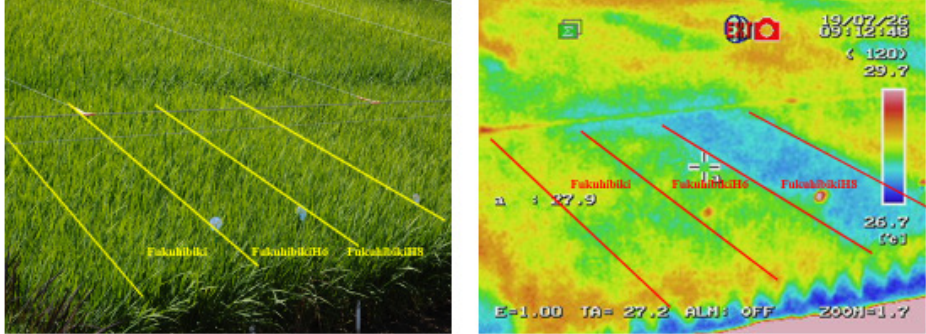
Figure 4. Yield evaluation ( left ) and thermo-camera observation ( right ) of FukuhibikiH6 and FukuhibikiH8 at maximum tillering stage in paddy field in Ibaraki, Japan, in 2019. Note: thermo-camera was “InfReC R300SR-S” of AVIONICS CO., LTD.